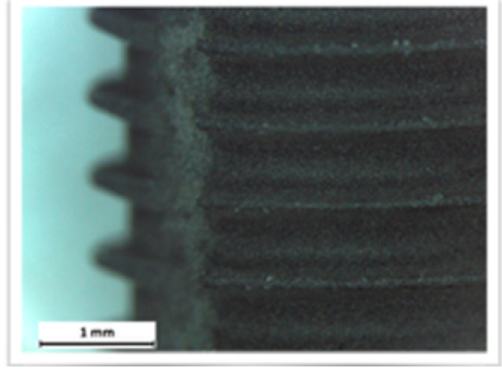
Figure 1. Competitor 1 .